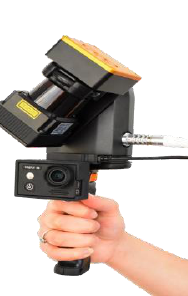
Figure 1: Leica C10.